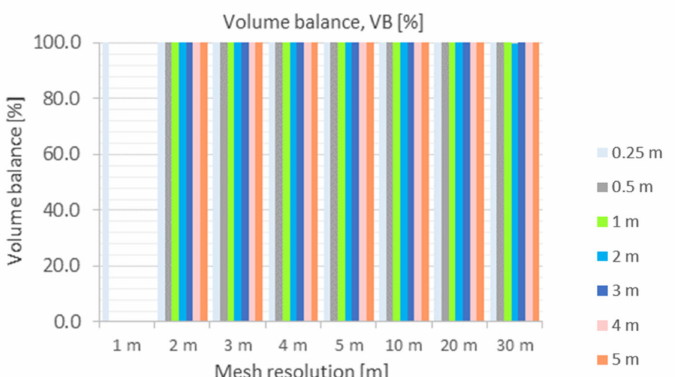
Figure 21. Overview of results of VB for the different mesh and DEM resolutions (DEM: colored